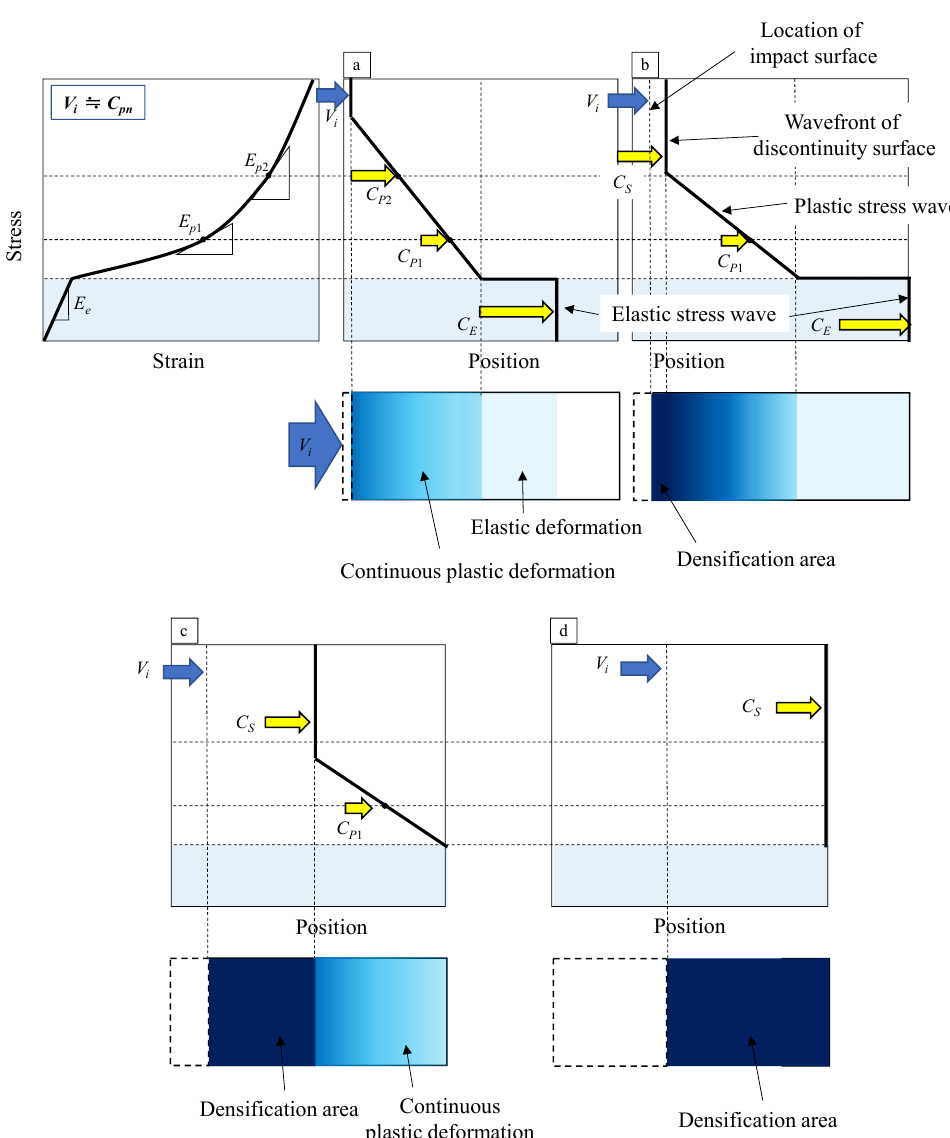
Figure 19. Stress wave propagation behavior where compression velocity is slightly higher than plastic stress wave speed: ( a – d ) correspond to the history of experimental results in Figure 14.